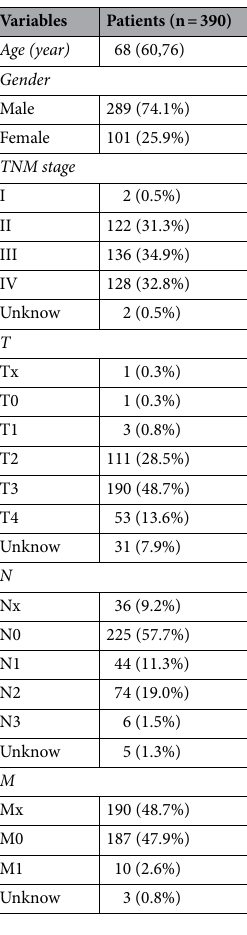
Table 1. Demographical characteristics and clinical data of the